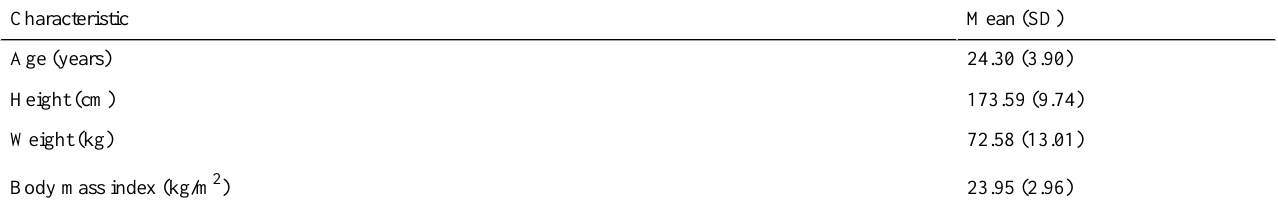
Table 1. Characteristics of sample (N=81